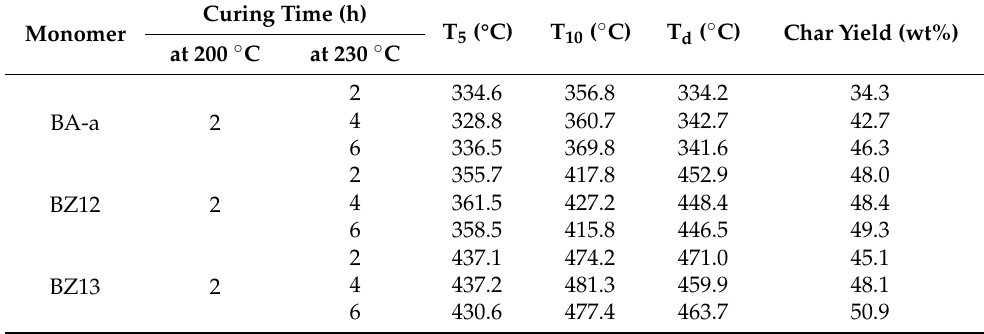
Table 2. The thermal properties o polybenzoxazines derived from BA-a, BZ12, and BZ13 [43].